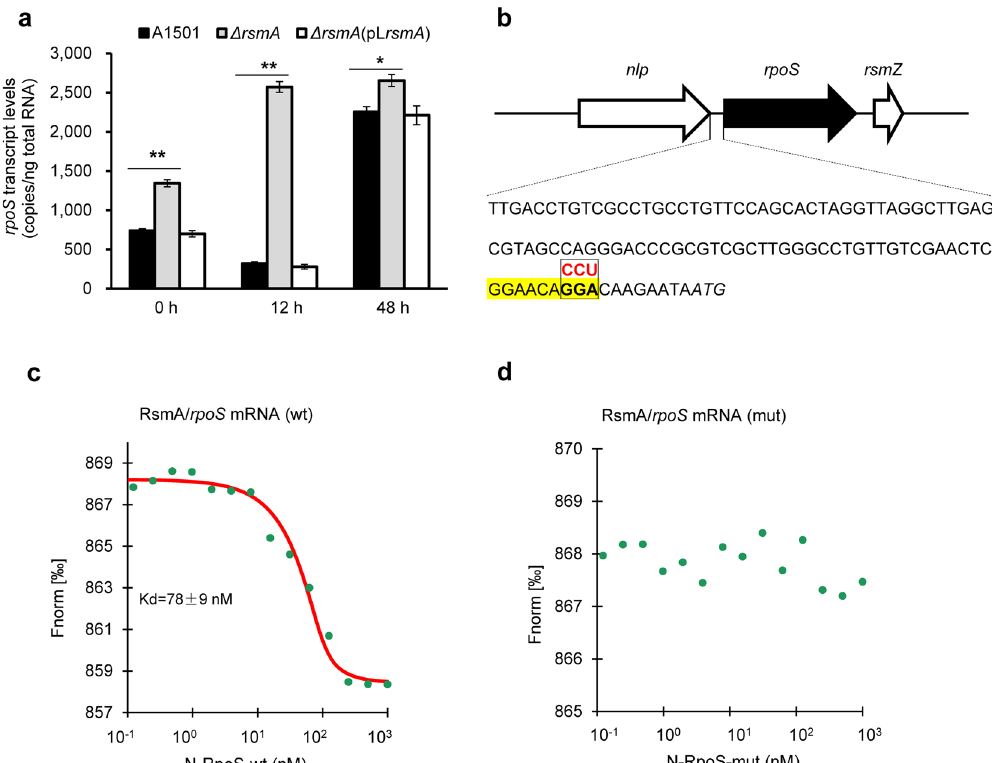
Fig. 5 Regulation of rpoS expression by RsmA. a Absolute transcription levels of the rpoS gene measured using ddPCR at different stages of nitrogen- fi xing bio fi lm formation by the WT A1501, rsmA mutant, and corresponding complemented strains. 0 h: initial inoculation; 12 h: early stage; 48 – 96 h: mature stage. Asterisks indicate statistical signi fi cance when compared to the wild-type control by one-way ANOVA with LSD multiple-comparison test: * p < 0.05; ** p < 0.01. b The rpoS promoter region of P. stutzeri A1501. The GGA motif is shown in red, and the corresponding mutated sequence in the synthesised oligonucleotide N-RpoS-mut, containing the 5 ′ -UTR of rpoS mRNA, is shown above the GGA motif. The putative ribosome-binding site (RBS) site is highlighted in yellow. The ATG initiation codon of rpoS is indicated in bold and italics. c , d Determination of the af fi nity of Cy3-labelled RsmA binding to oligonucleotides containing the WT or mutated motifs, respectively, demonstrated by MST analysis. Ligand-dependent changes in MST are plotted as normalised fl uorescence ( F norm ) values vs. ligand concentration in a dose – response curve. F norm values are plotted as parts per thousand [ ‰ ] for binding af fi nity analysis. N, ssRNA oligonucleotide; wt, wild type; mut, mismatch